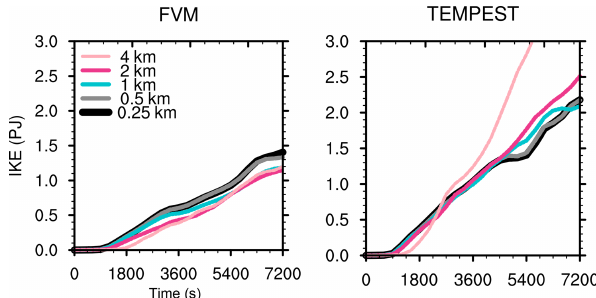
Figure 9. As in Fig. 7 except showing the subset of models that completed a 0.25km